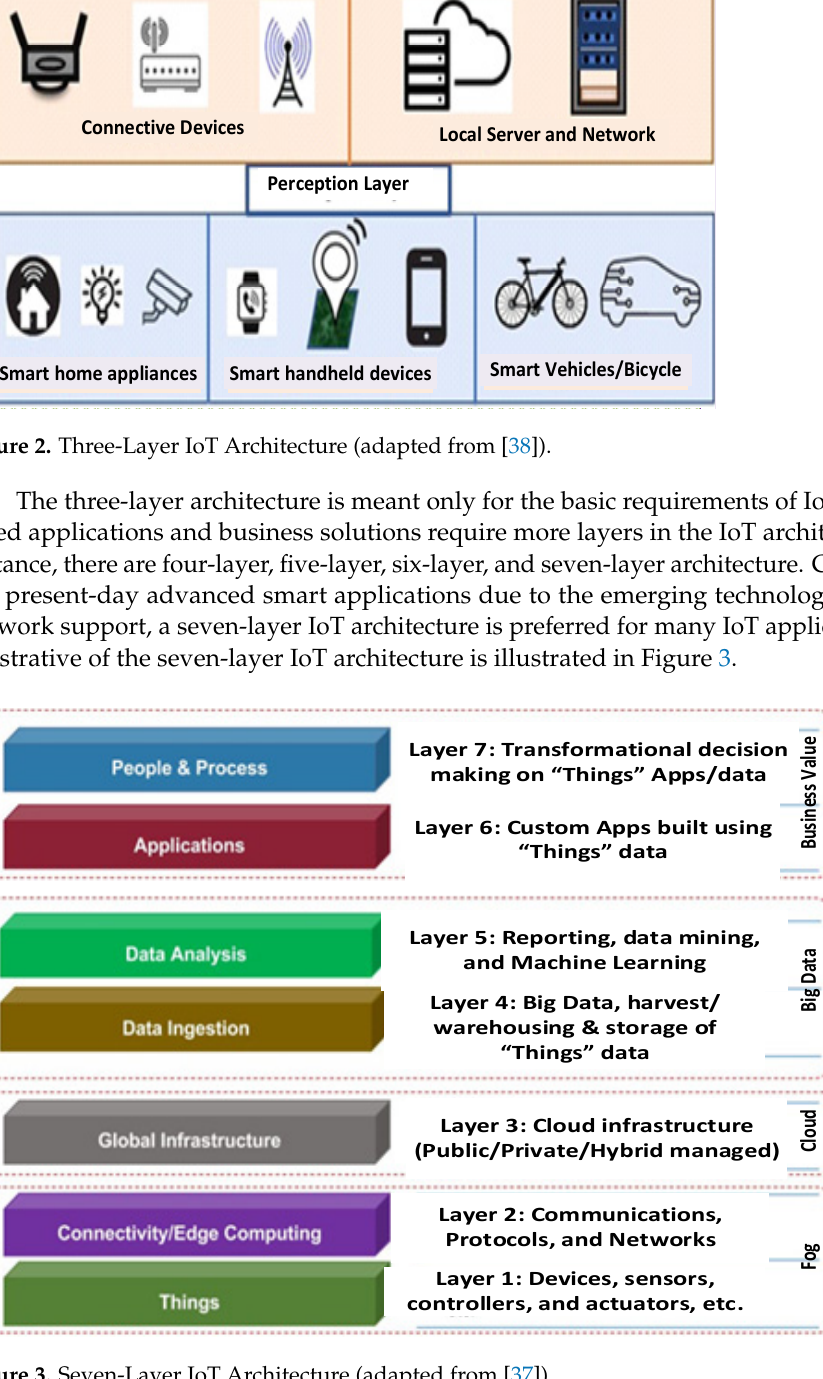
Network Server Figure 4. Typical LPWAN Architecture.